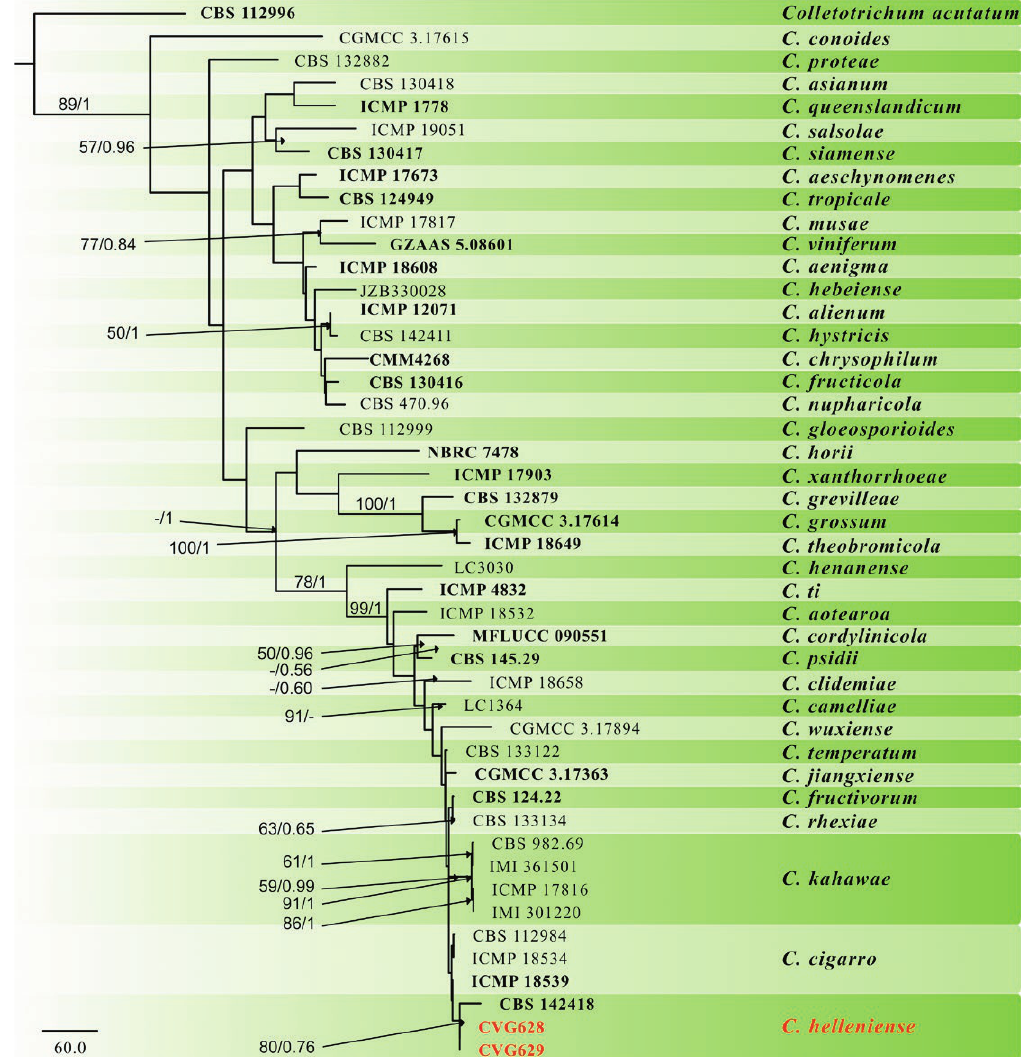
Figure 2. Maximum parsimony (MP) best-tree phylograms obtained from 46 Colletotrichum gloeosporioides species complex strains. Num- bers on the nodes are MP bootstrap and Bayesian posterior probability values. Isolates obtained from Vaccinium in the present study are indicated in red font. Ex-type strains are indicated in bold. The tree was rooted to Colletotrichum acutatum (CBS